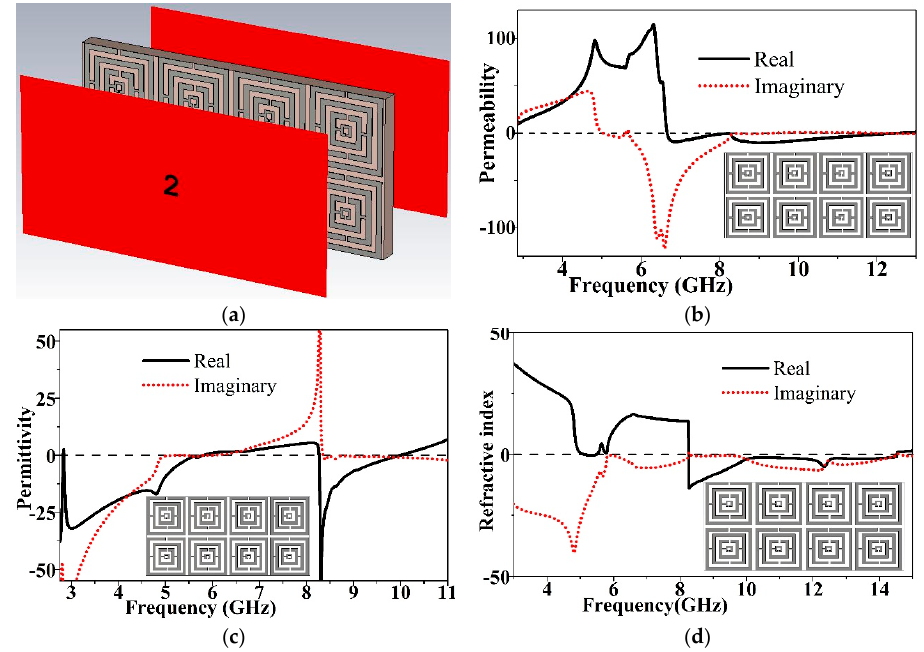
Figure 6. 2 × 4 array configuration characteristics ( a ) Simulation setup ( b ) Permeability ( c ) Permittivity ( d ) Refractive index.